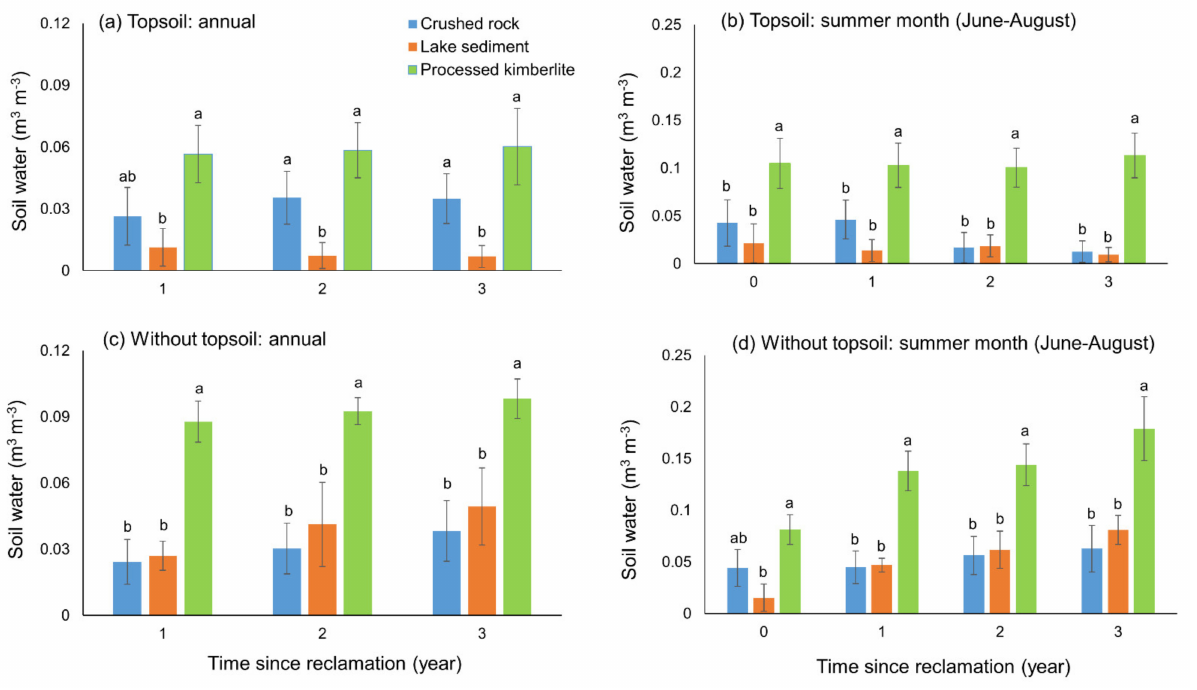
Figure 6. ( a – d ) Mean annual and summer month water content by topsoil treatments and substrate types at the research sites. Different letters indicate significant differences at p = 0.05 in Tukey HSD post hoc comparisons.